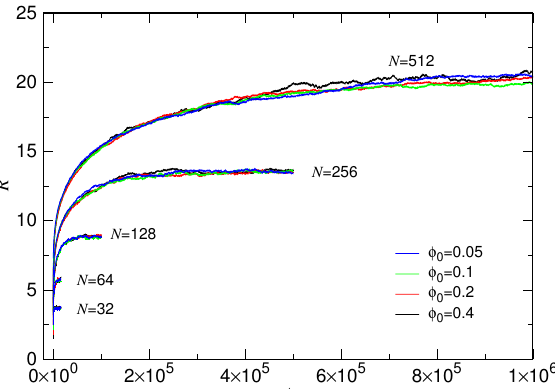
Figure 3. Averaged variation of chain size R ( t ) , for chain length N = 32, 64, 128, 256, and 512 released from φ 0 = 0.4, 0.2, 0.1, and 0.05. The chain length is indicated near the corresponding group of the curves, while the volume fraction is given in the